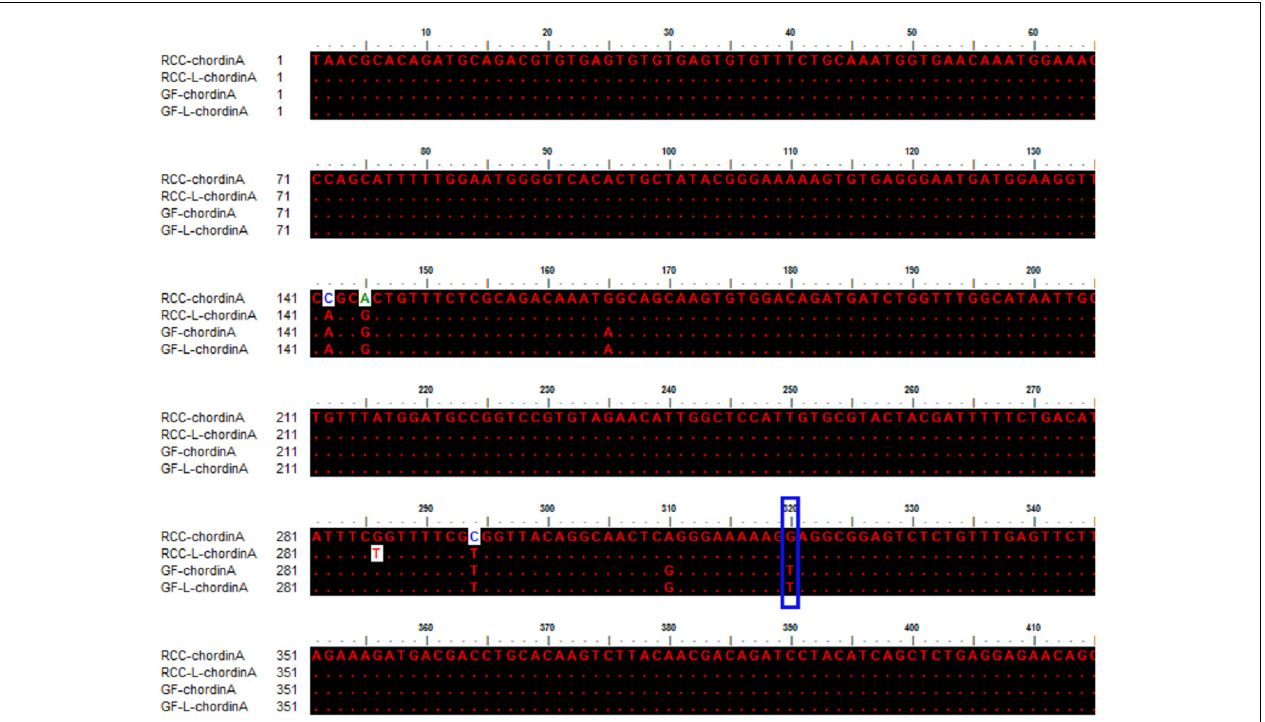
FIGURE 6 | Sequence comparison of chordinA in RCC, RCC-L, GF-L, and GF. The blue box represents the mutation base regarding the formation of twin tails. The dots represent the same base. TABLE 6 | The percentages of nucleotide identity of 5S rDNA sequences in RCC-Land GF-L compared with the genomes of related species. Common carp genome Blunt snout bream genome Red crucian carp genome Alignment Alignment Alignment Alignment Alignment Alignment Alignment similarity location length similarity location length